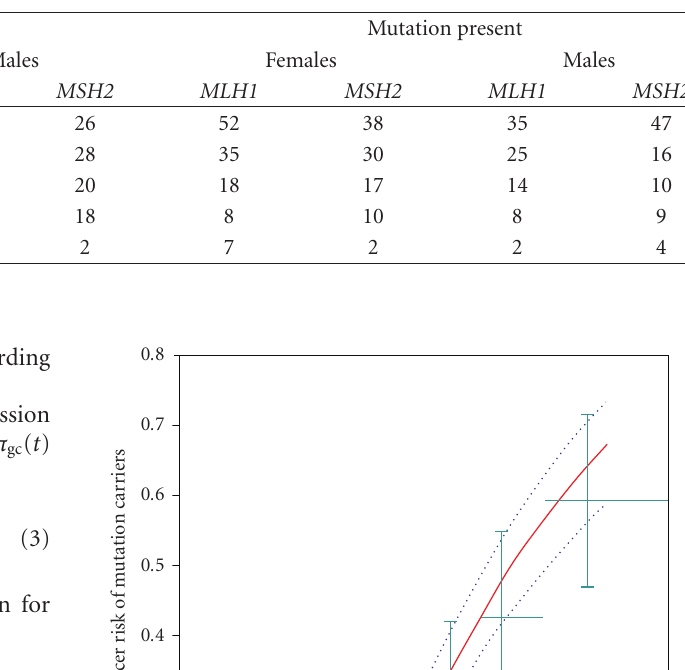
Table 1: Distribution of mutation carrier and non carrier in 859 una ff ected individuals with one 1st degree relative carrying a deleterious MSH2 or MLH1 mutation.